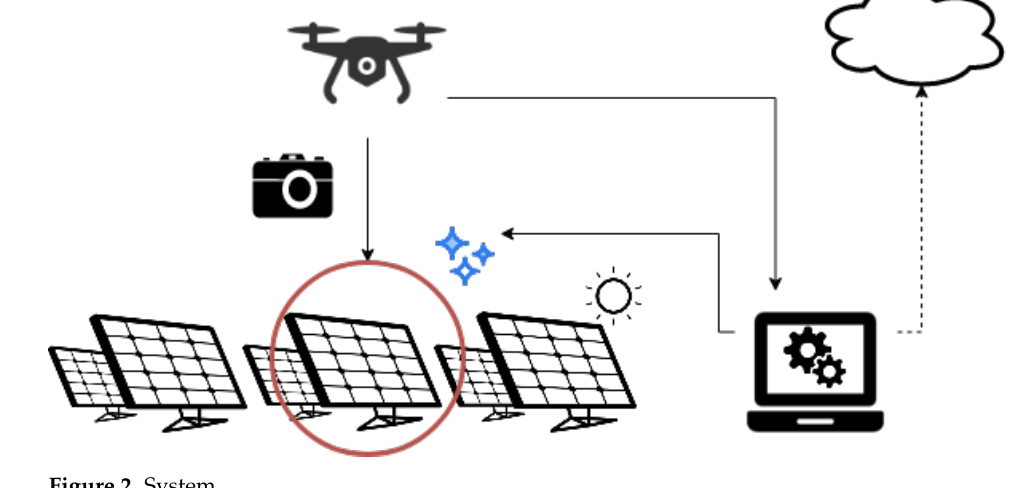
Figure 2. System.